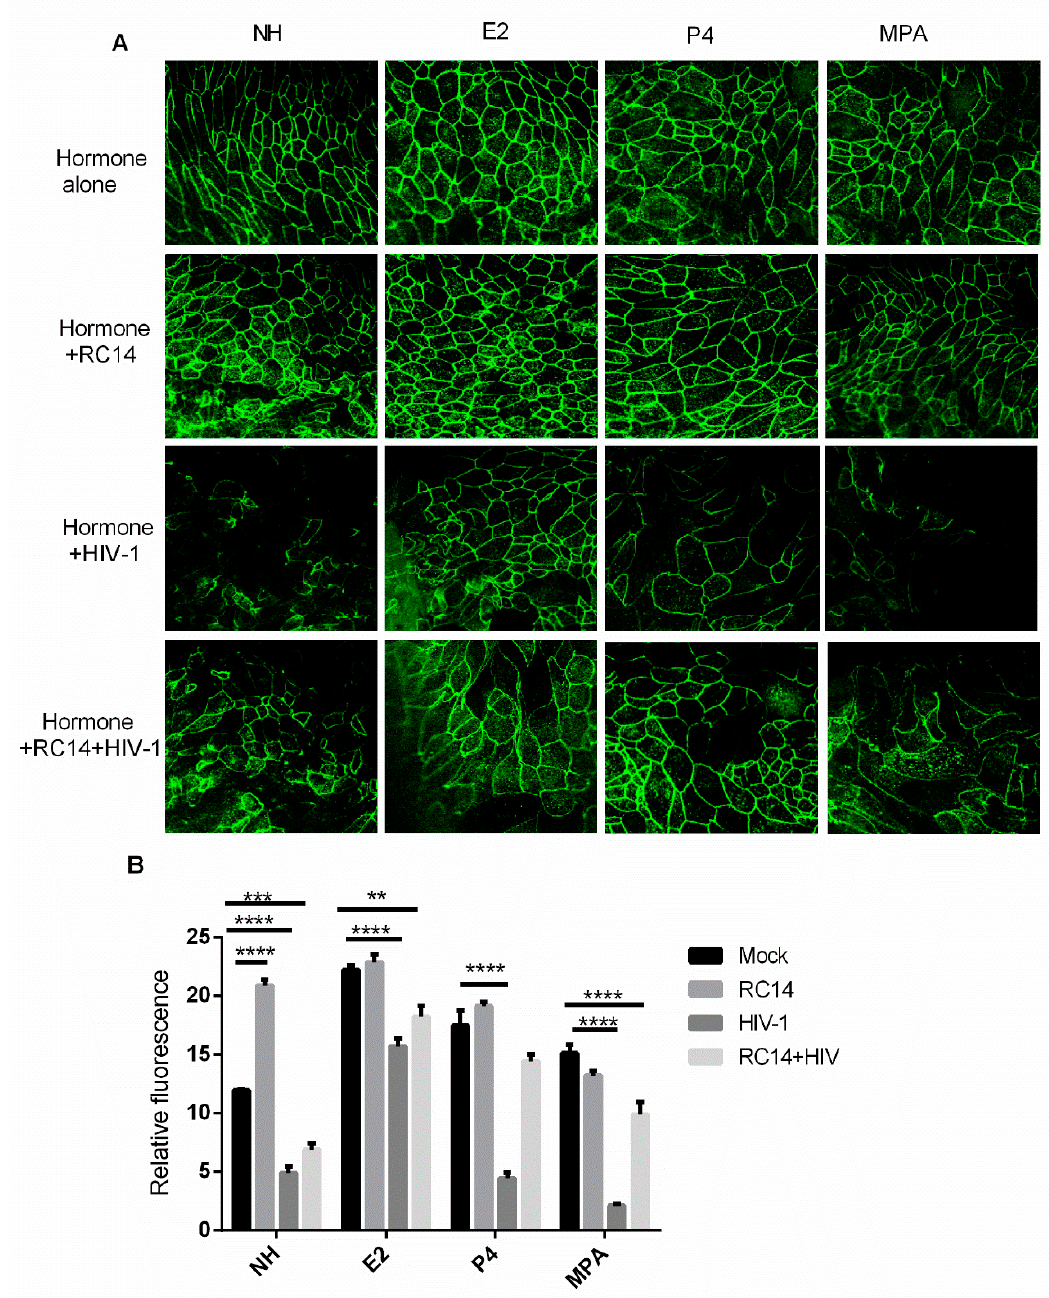
Figure 6. Probiotic lactobacilli and estrogen protect GECs from HIV-1-mediated tight junction degradation. GECs were grown in the presence or absence (NH) of E2, P4 or MPA until confluence was reached. Confluent GECs were pre-treated for 2 h with L. reuteri (RC-14) at 100 CFU / cell or no bacteria. After pre-treatment, non-adherent lactobacilli were removed, and primary GEC were exposed to HIV-1. After 24 h, cells were fixed and stained for ZO-1 tight junction proteins. Images were captured with Olympus confocal microscope. Representative images ( × 1260 magnification) of each culture condition are shown ( A ). Fluorescence of 3 di ff erent images taken for each culture condition (see Methods for details) and were measured by Image J software ( B ). Data is plotted as mean + SEM of relative fluorescence. Statistical significance is indicated: **** p < 0.0001, *** p < 0.001, ** p < 0.01.